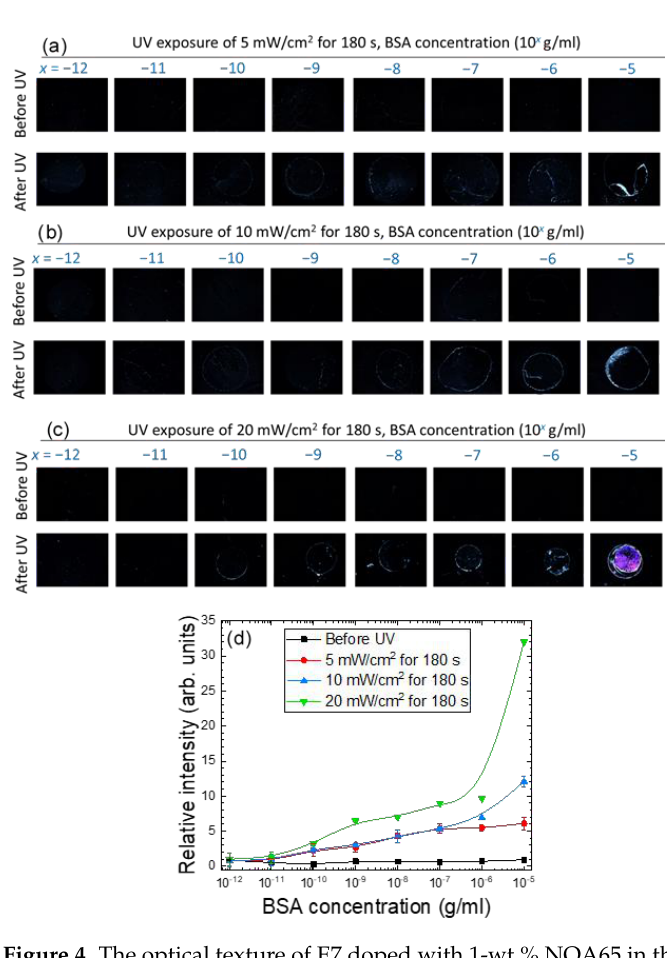
Figure 4. The optical texture of E7 doped with 1-wt.% NOA65 in the presence of immobilized BSA molecules at concentrations ranging from 10 −12 to 10 −5 g/mL, followed by LC cell assembly and UV irradiation at ( a ) 5, ( b ) 10 or ( c ) 20 mW/cm 2 for 180 s. The brightness of the optical textures in ( a – c ) was quantitated with ImageJ and plotted against the BSA concentration in ( d ). Error bars represent standard deviations calculated from the relative intensities of at least three independent